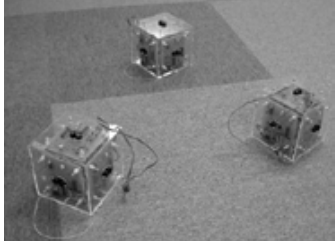
fig. 7. DOLPHIN units, picture from Fukuju et al.